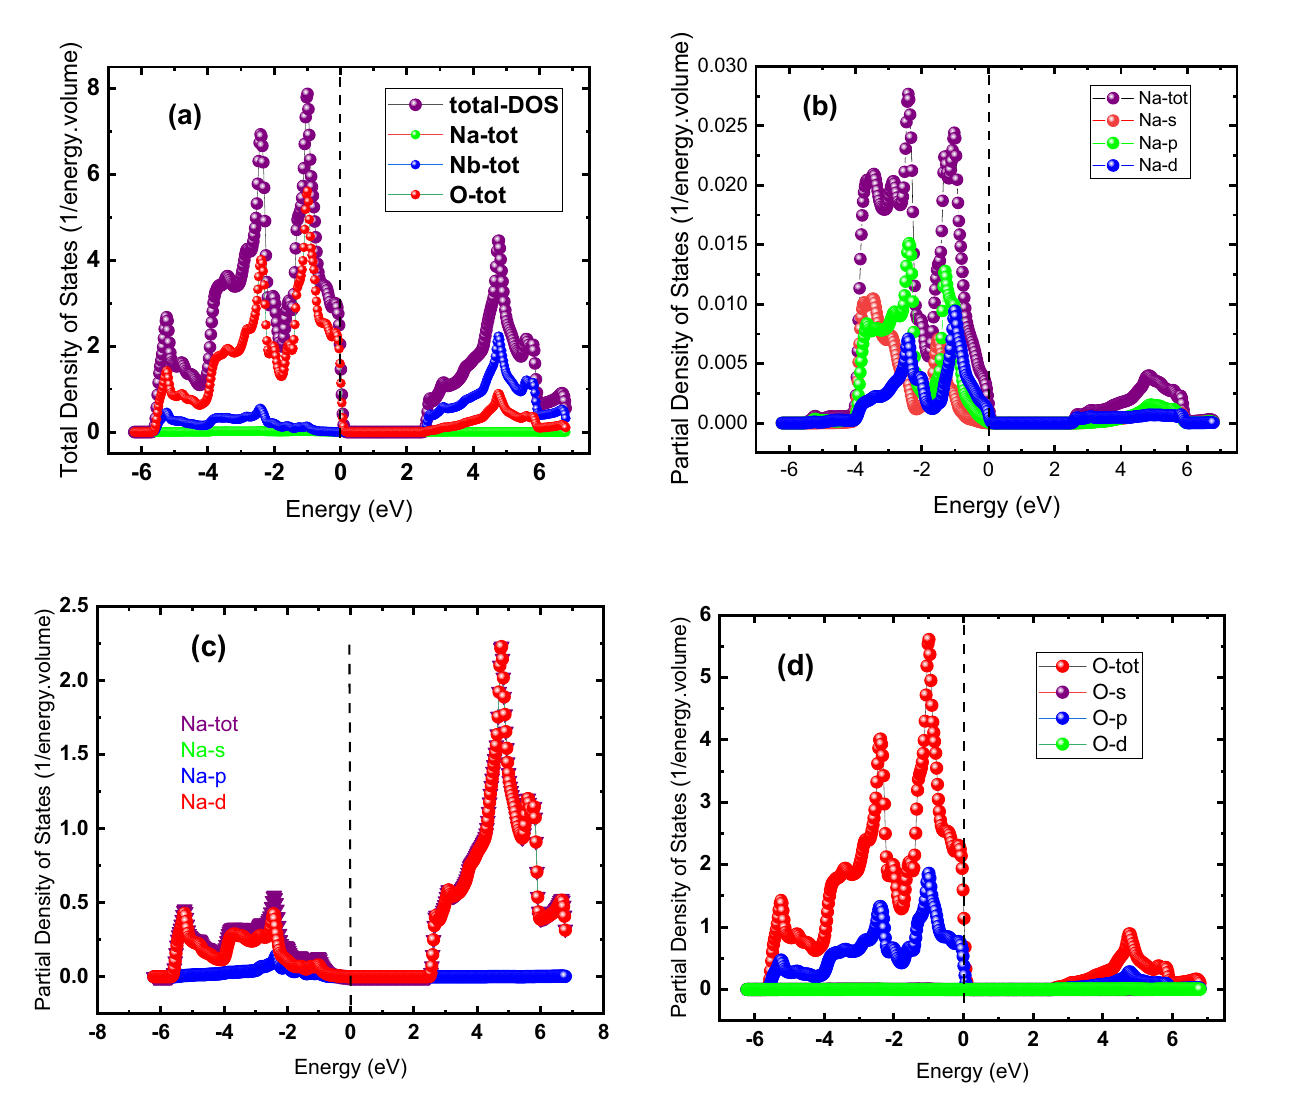
Figure 5. (Color online) DOS for NaNbO 3 oxide perovskites ( a ) TDOS and PDOS for ( b ) Na, ( c ) Nb and ( d )